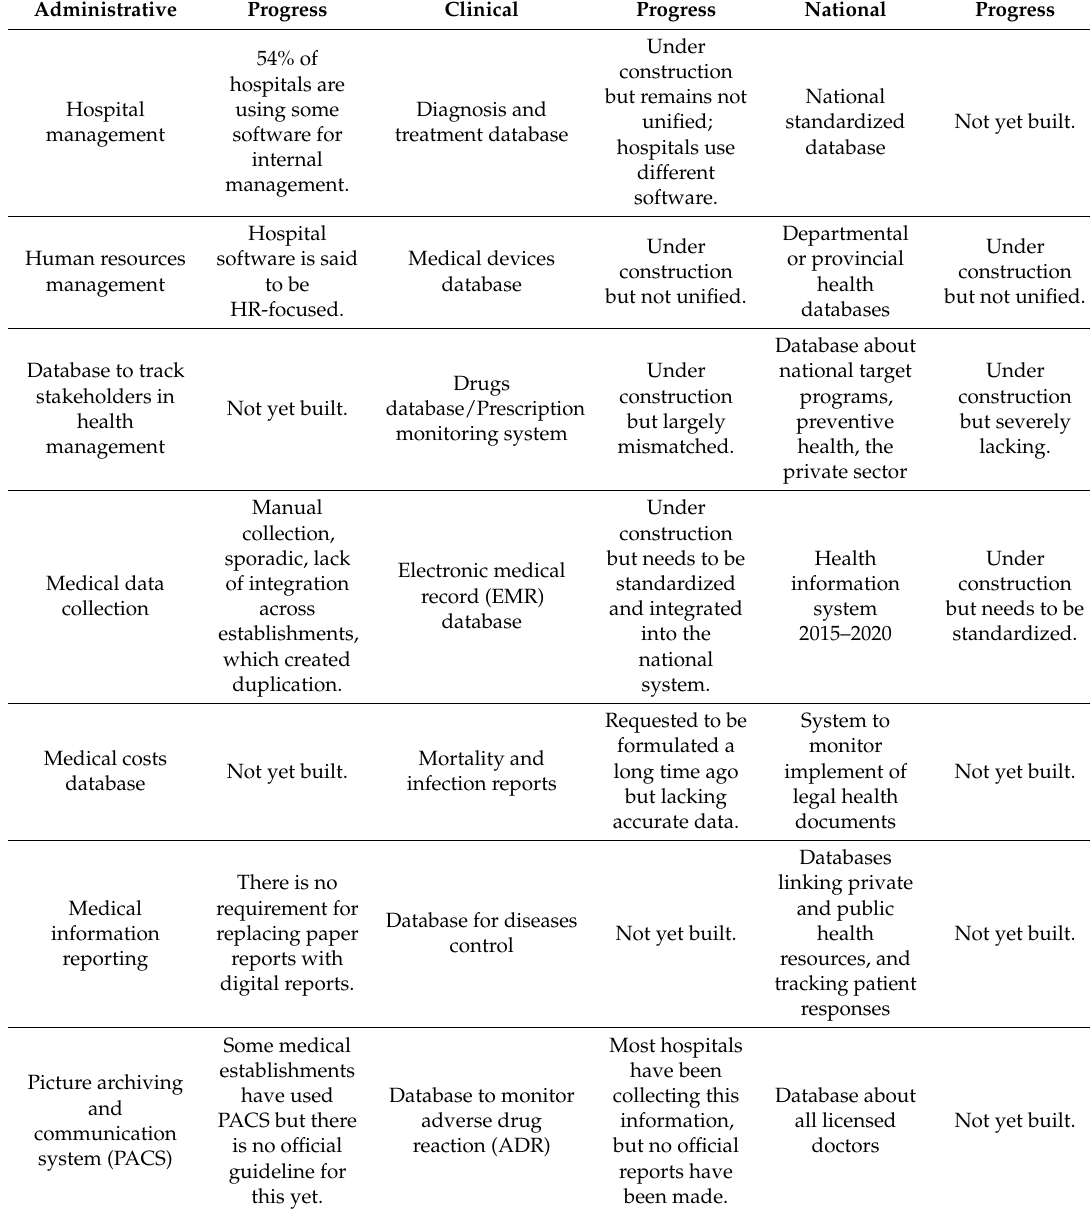
Table 3. The utilization (or lack thereof) of information technology in Vietnam’s healthcare sector, categorized in three groups: administrative, clinical, and